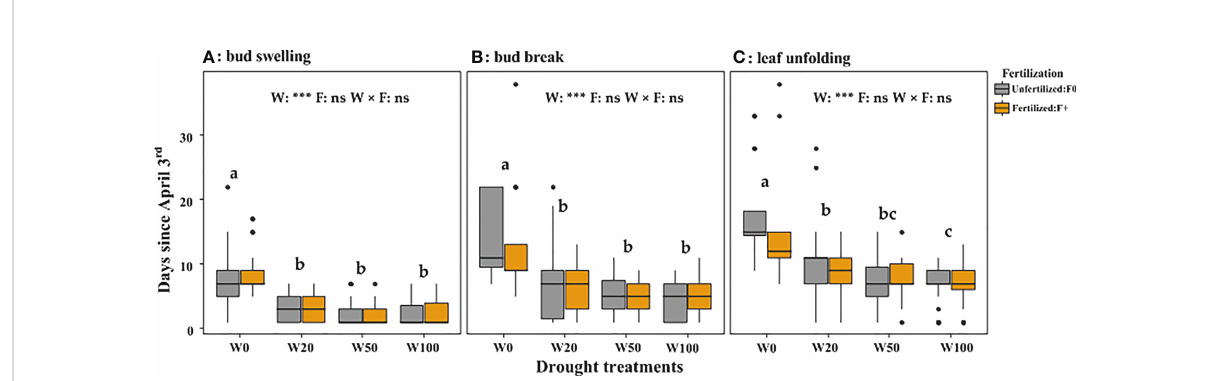
FIGURE 4 Number of days since April 3 rd 2017 until bud swelling (A) , bud break (B) or leaf unfolding (C) for trees in the different drought and fertilization treatments. The drought treatments depicted as W100, W50, W20, and W0, represents 100%, 50%, 20%, and 0% of soil moisture at the fi eld water capacity, respectively. Different lower cases letters indicate statistical differences ( p < 0.05) among drought